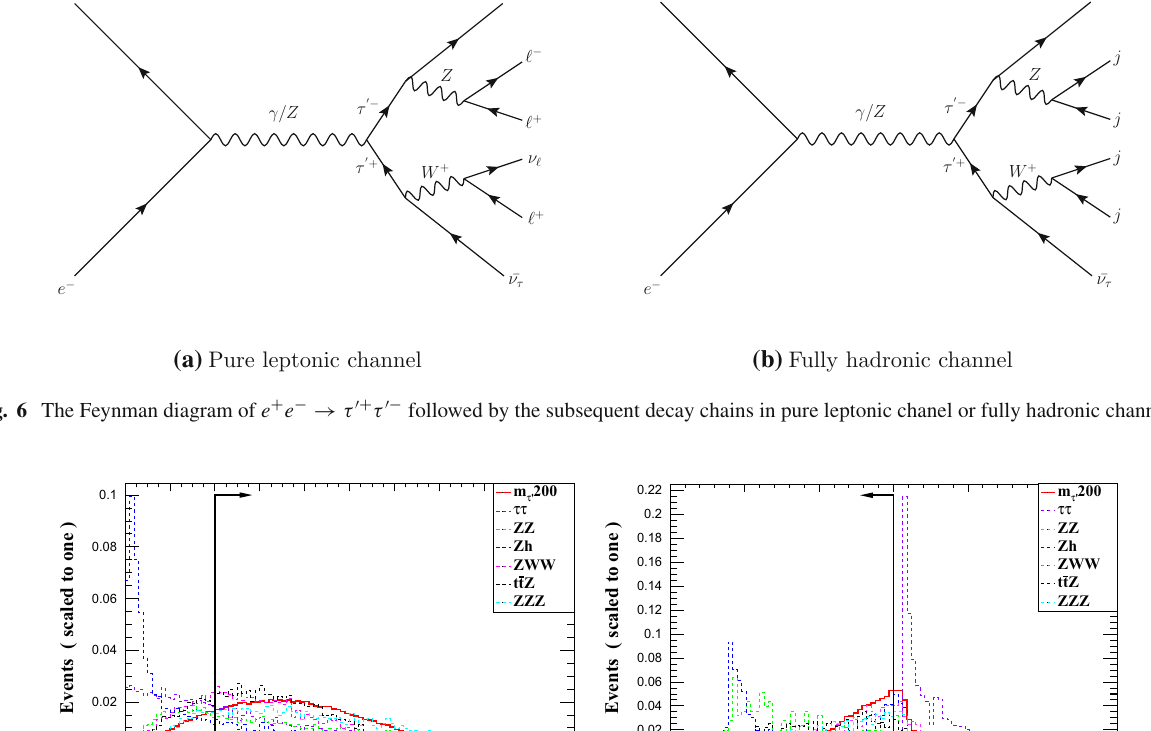
Fig. 7 Normalized distributions of the / E T and (cid:11) R (τ 1 ,(cid:10) 1 ) in the signal and backgrounds at dashed lines stand for background events and black arrows indicate our selection